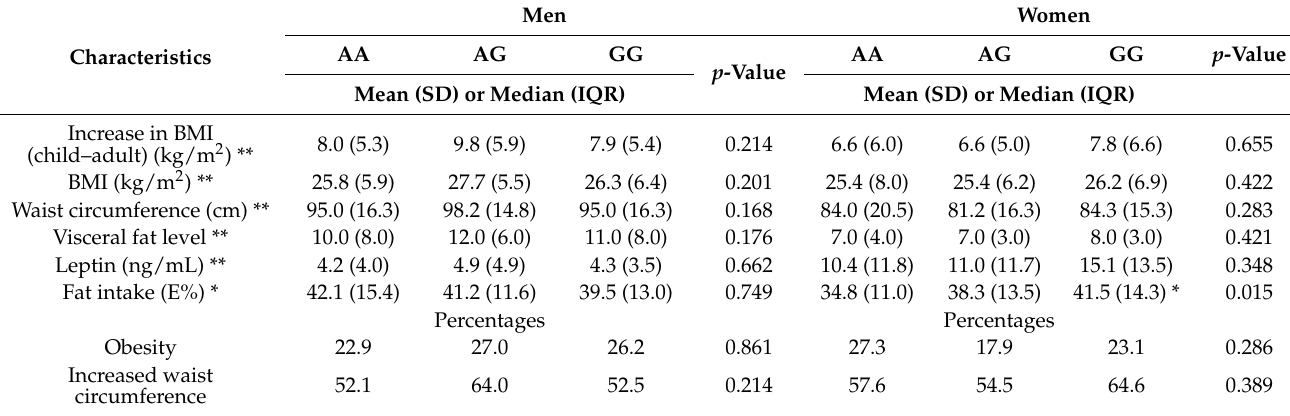
Table 8. Association of the LEPR rs1137101 polymorphisms with anthropometric measurements and other factors in adulthood.